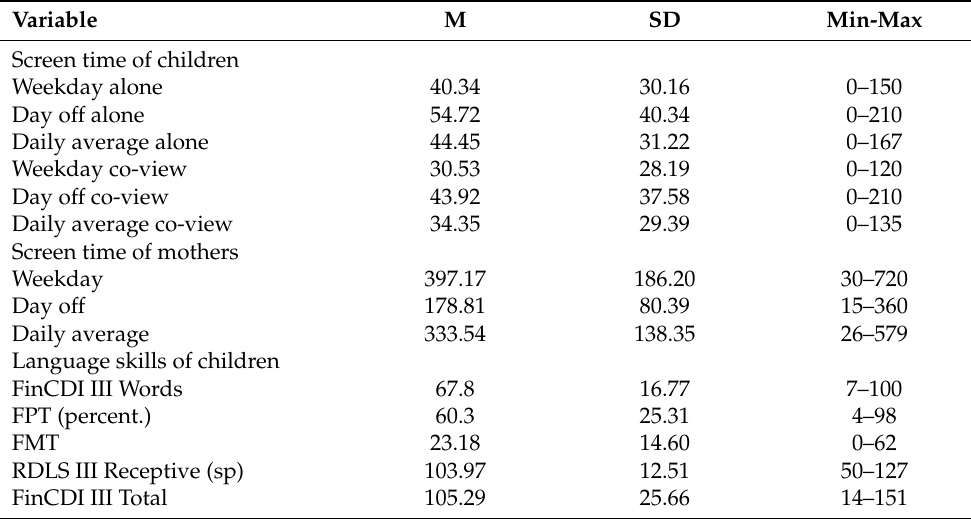
Table 2. Descriptive statistics for screen time of children (alone and co-view) and mothers presented in minutes, and for children’s language test